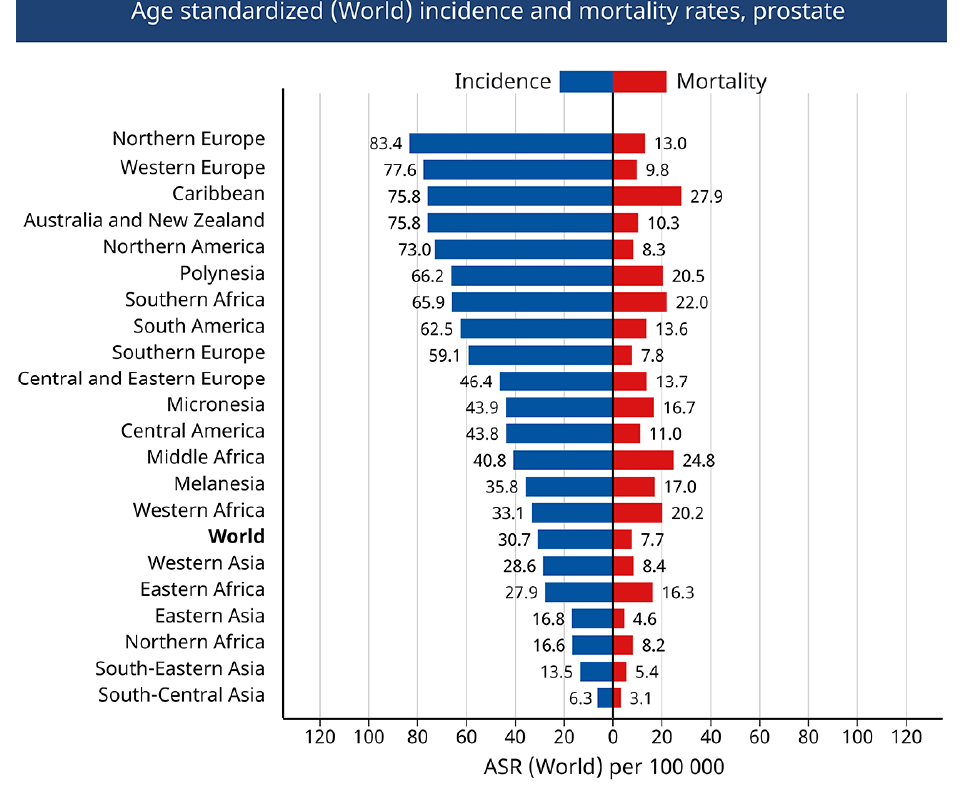
Figure 2. Incidence and mortality rates by age group for PCa in 2020. Source: GLOBOCAN 2020. PCa is diagnosed in only 2% of cases in people under the age of 50, and over 60% of patients are diagnosed after the age of 65 [22]. In 2018, the Task Force on Chronic Disease in the USA proposed screening for PCa in men aged 55 to 69 years [23]. In addition, patients with well, moderately, and poorly differentiated tumors had 10-year CSS rates of 91%, 90%, and 74%, respectively [24]. The overall PCa mortality based on studies from 185 countries is shown in the Figure 2 [21]. Roughly, active treatment is indicated in patients with local disease and life expectancy over 10 years. Patients who have not received local treatment have a cancer specific survival (CSS) rate of 82–87% after 10 years